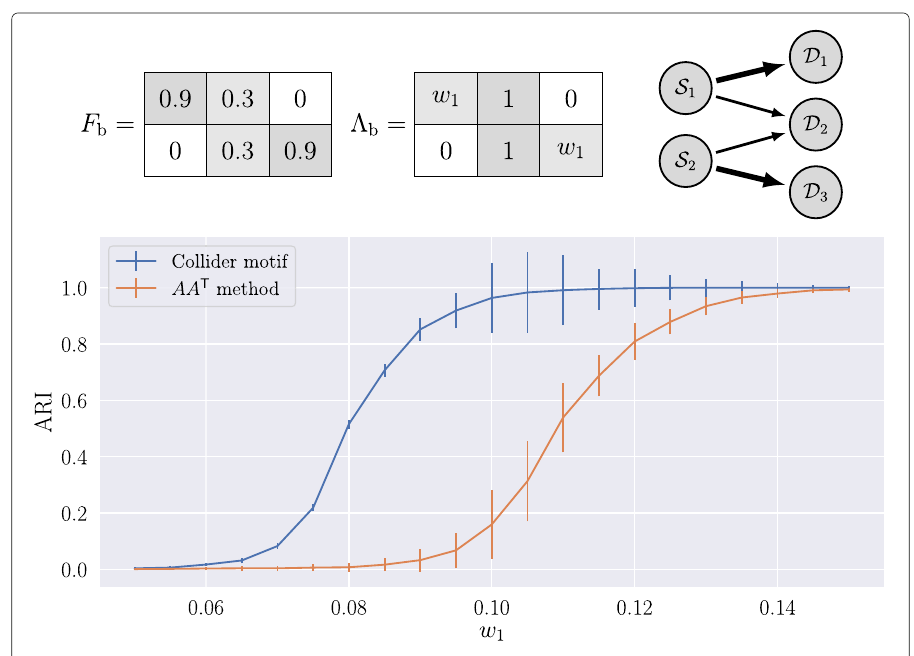
Fig. 9 Top: BSBM parameters for Example 3 Experiment 2. Left panel is the connection matrix, middle panel is the weight matrix (see Eq. 6 and Section 4.2 for details), right panel is a diagram of the block structure, with arrow widths representing connection probabilities. Bottom: performance of our bipartite collider method vs. clustering based on AA T . We perform 100 repeats, and error bars are one sample standard